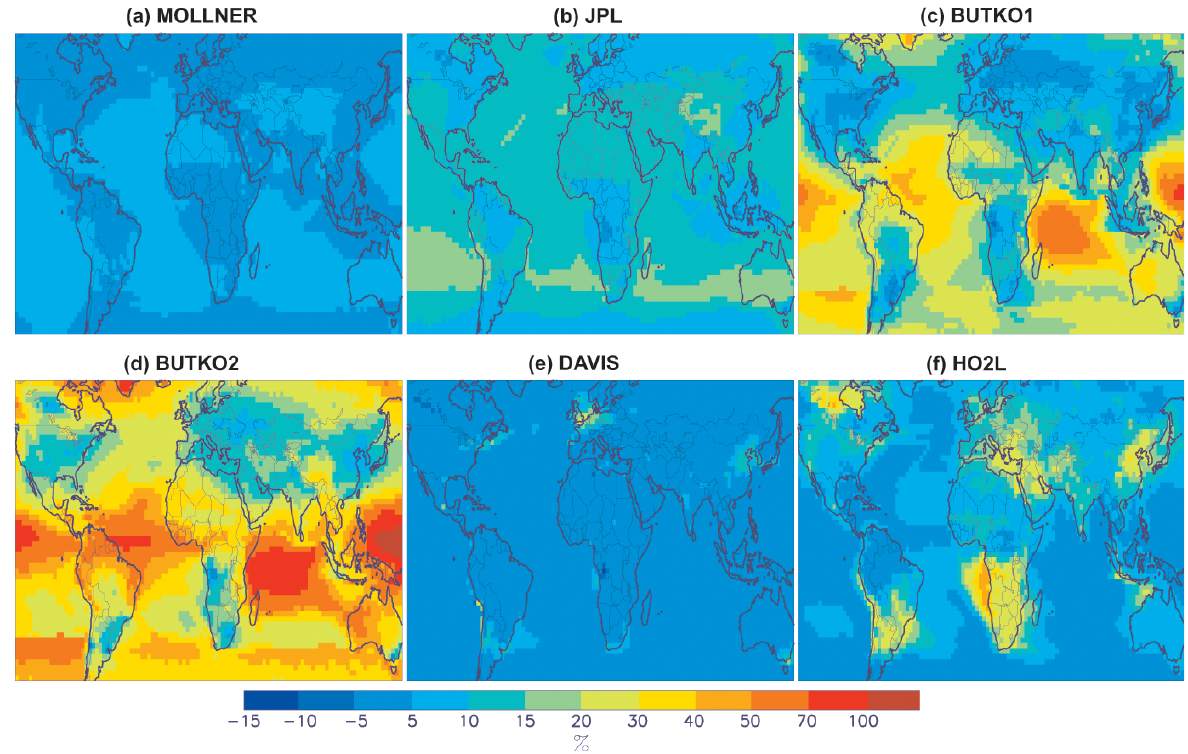
Fig. 3. Same as Fig. 2 for July